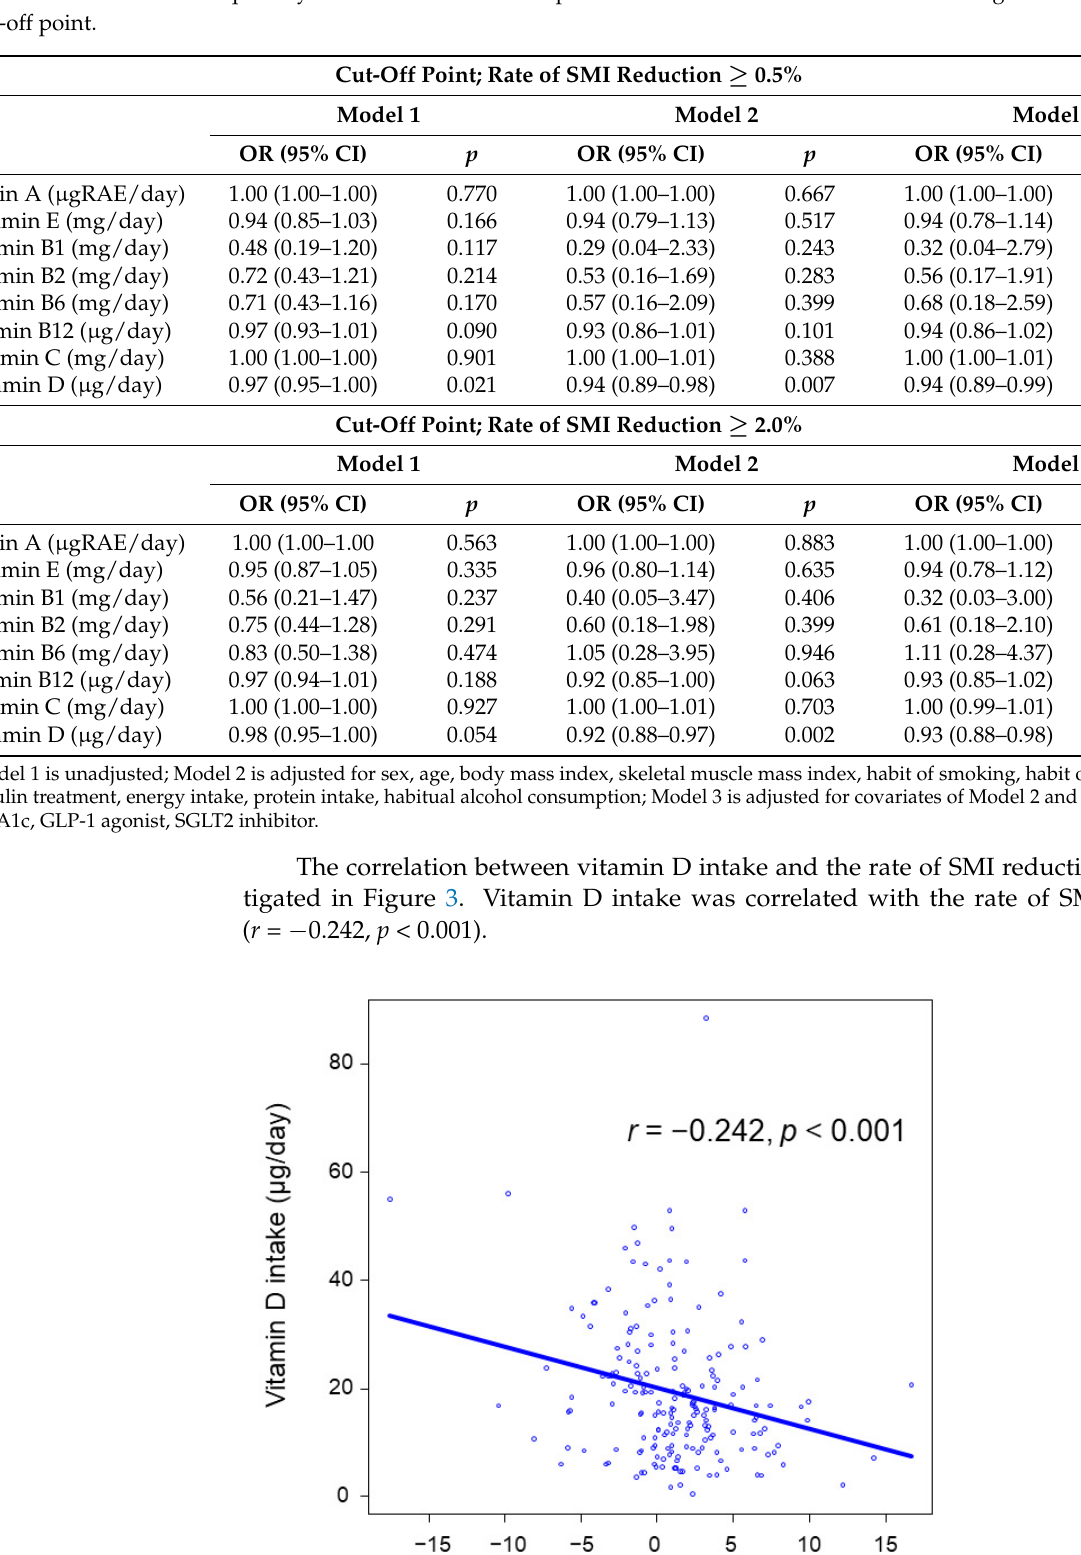
Figure 3. The correlation between vitamin D intake and the rate of SMI reduction. SMI, skeletal muscle mass